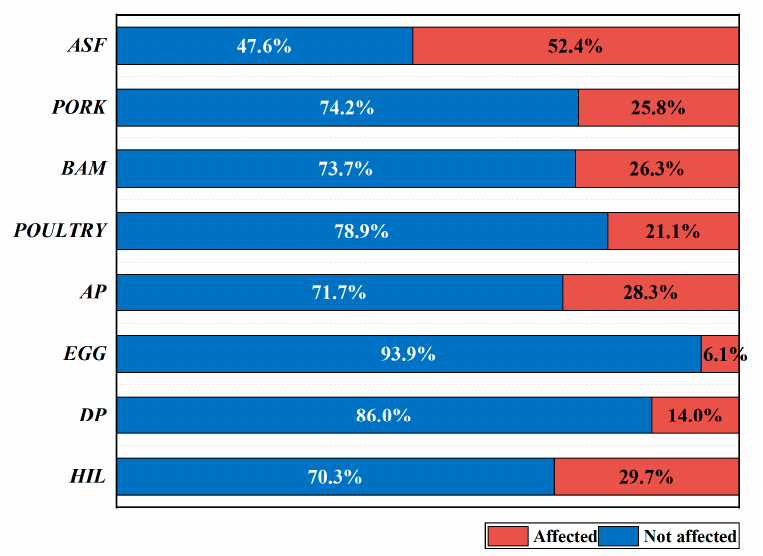
Figure 1. The impact on consumption of animal-source foods and household income. Note: ASF = consumption of animal-source foods; PORK = consumption of pork; BAM = consumption of beef and mutton; POULTRY = consumption of poultry; AP = consumption of aquatic products; EGG = consumption of eggs; DP = consumption of dairy products; HIL = household income.